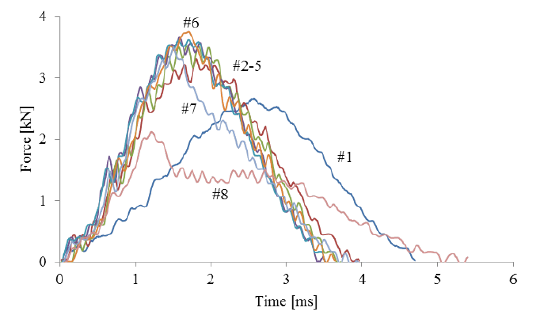
Figure 5. Mean force-time